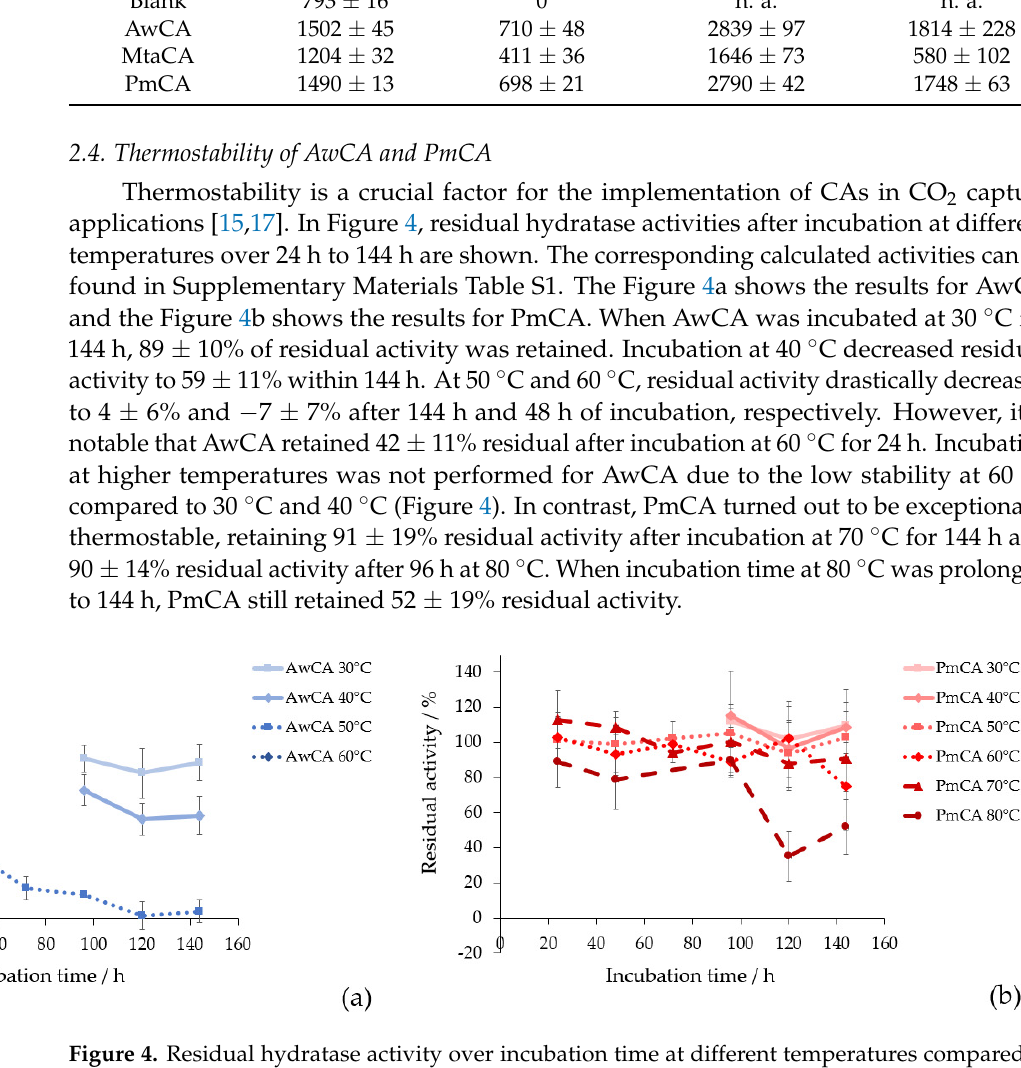
Figure 4. Residual hydratase activity over incubation time at different temperatures compared to unincubated enzyme for ( a ) AwCA at 30 °C, 40 °C and 50 °C; ( b ) PmCA at 50 °C, 60 °C, 70 °C, 80 °C. unincubated enzyme for ( a ) AwCA at 30 ◦ C, 40 ◦ C and 50 ◦ C; ( b ) PmCA at 50 ◦ C, 60 ◦ C, 70 ◦ C, 80 ◦ C. n = 3. n =